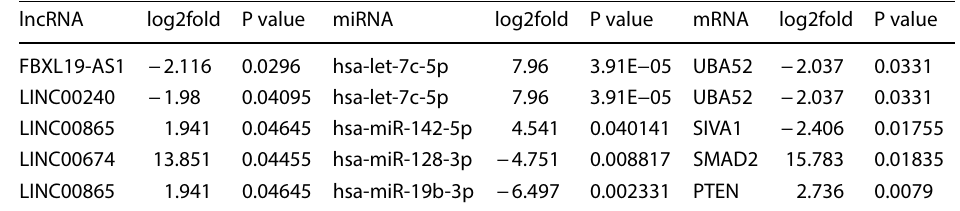
Table 17 The significantly differentially expressed lncRNAs in OS-R compared to OS showing correlative expression with miRNAs and mRNAs